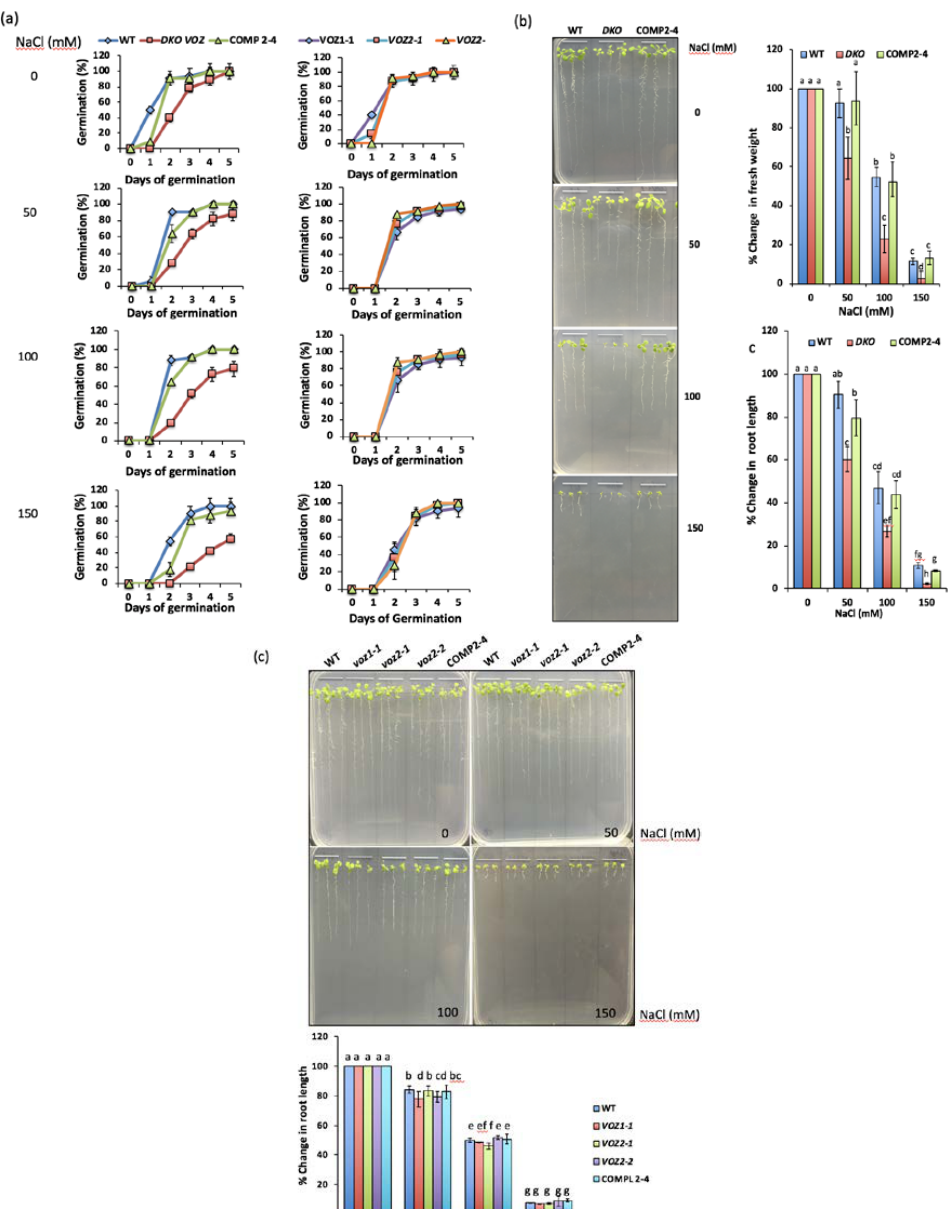
Figure 7. Germination and seedling growth of WT, mutants and complemented line in the presence of NaCl. ( a ) VOZ Double mutant (DKO) exhibits delayed germination under salt stress. The time course of seed germination of WT, DKO, COMP2-4 (left panels), voz1-1 , voz2-1 and voz2-2 (right panels) in the presence of 0, 50, 100 and 150 mM NaCl. Each value shown here is mean of three biological replicates with n = 10. The error bars represent SD. ( b ) VOZ Double mutant (DKO) is hypersensitive to salt stress. Left panel: Growth of seedlings of WT, DKO and COMP2-4 on MS (Murashige and Skoog medium) plates containing different concentrations of NaCl. Seeds were plated on 1/2 strength MS medium supplemented with 0, 50, 100 and 150 mM of NaCl and were allowed to germinate and grow for two weeks. The photographs were taken after two weeks. Right panel, top: Seedling fresh weight. Right panel, bottom: Seedling root length at different concentrations of NaCl was measured for all genotypes and plotted as % relative to growth on normal (0 mM) MS medium. Three biological replicates were used. Eight to ten seedlings for each genotype per treatment for each biological replicate were